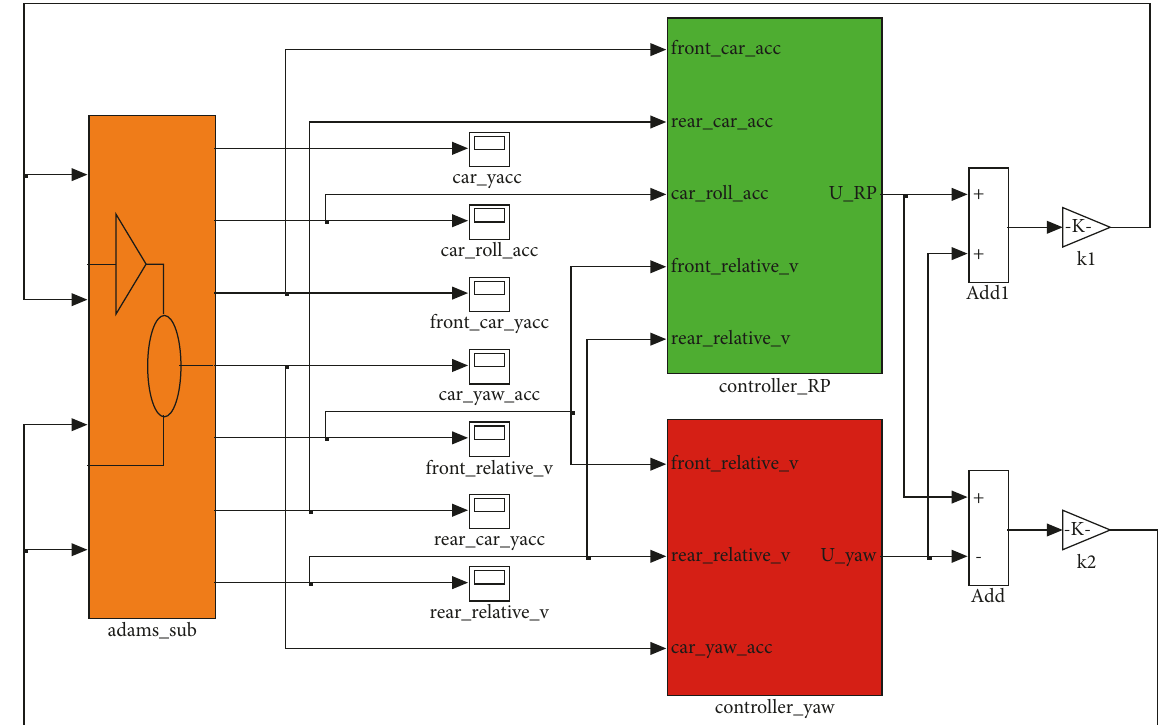
Figure 2: Robust nonfragile H ∞ controller of lateral semiactive suspension system of rail vehicle.